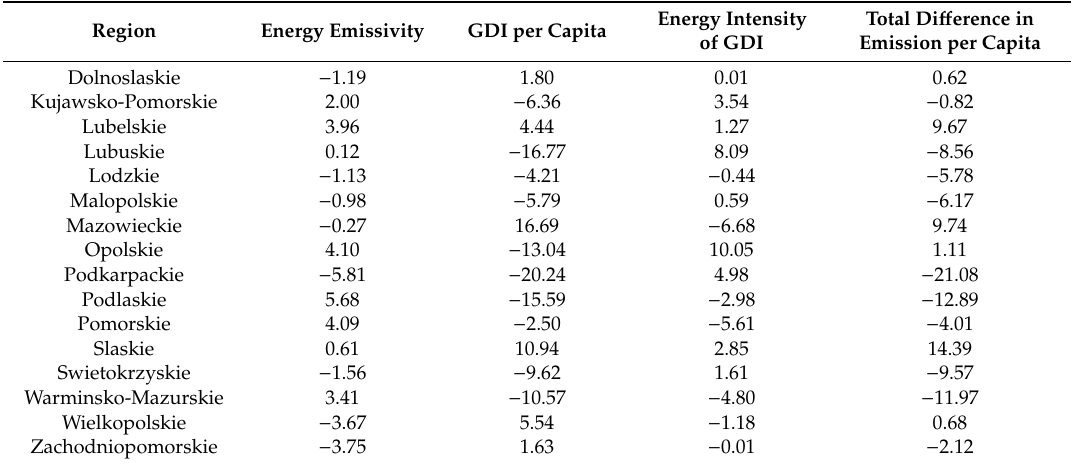
Table 6. Contribution of factors to the di ff erence in CO 2 emission per capita in households in 2006 capita [percentage points]. Source: Own calculation.